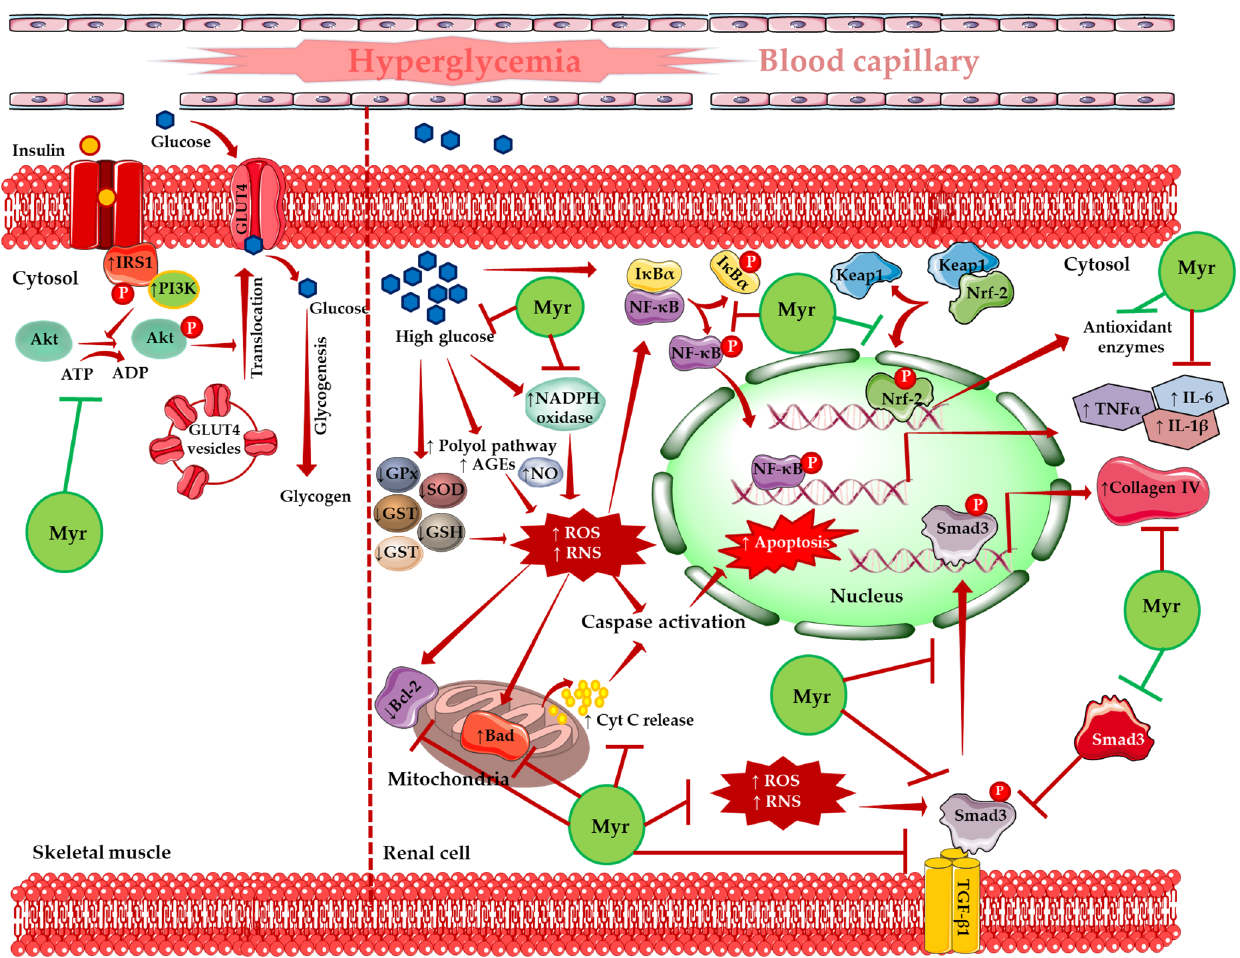
Figure 15. The possible mechanism of Myr in the management in glucose utilization and diabetic nephropathy. Red arrows indicate downstream pathway, red lines indicate inhibition, and green lines indicate activation.